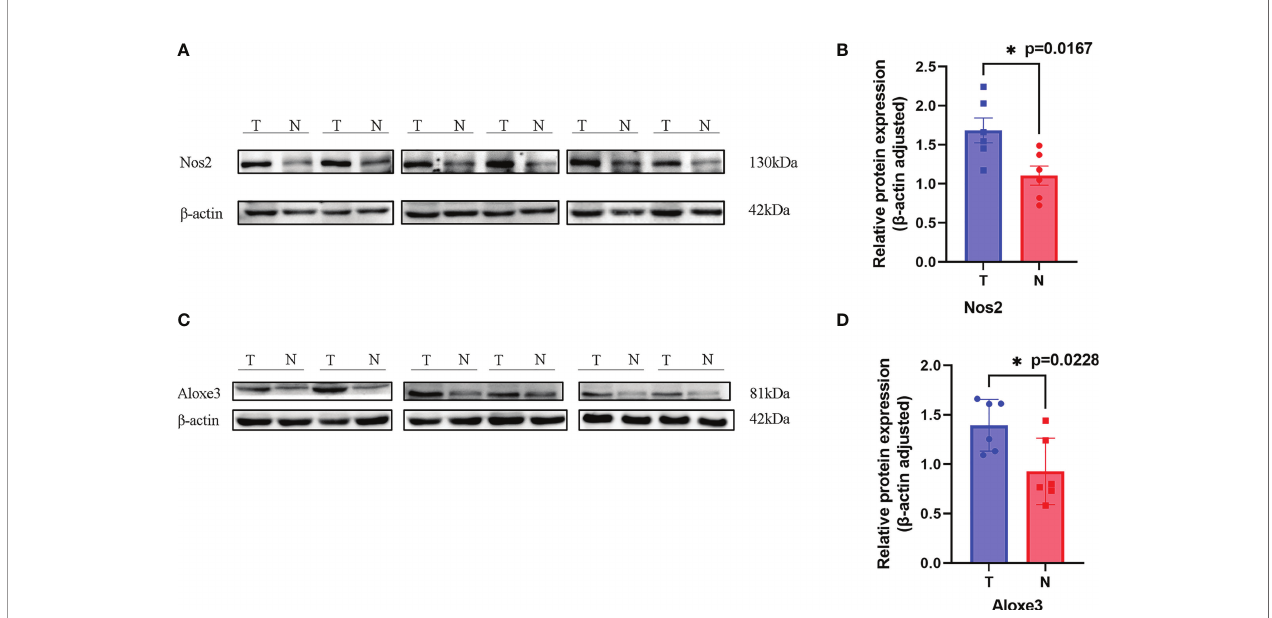
FIGURE 12 | Results of Western blotting. (A, C) . NOS2 and ALOXE3 were signi fi cantly more highly expressed in tumor tissues than in normal tissues. (T, Tumor; N, Normal) (B) . P = 0.0167 < 0.05, the difference was statistically signi fi cant. (D) . P = 0.0228, the difference was statistically signi fi cant. * p <